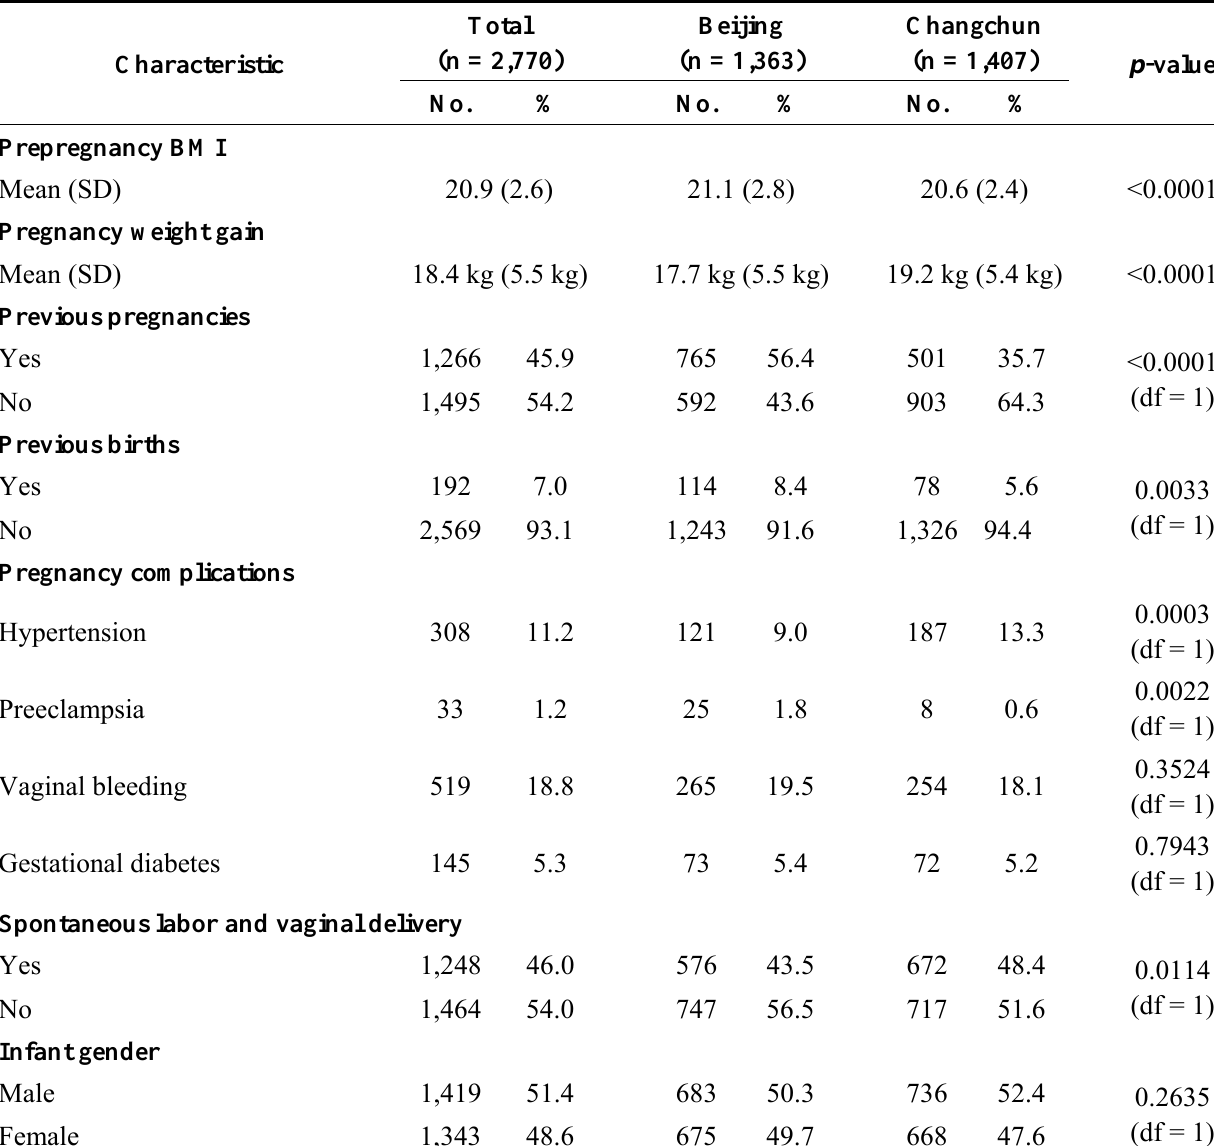
Table 3. Reproductive and perinatal characteristics of